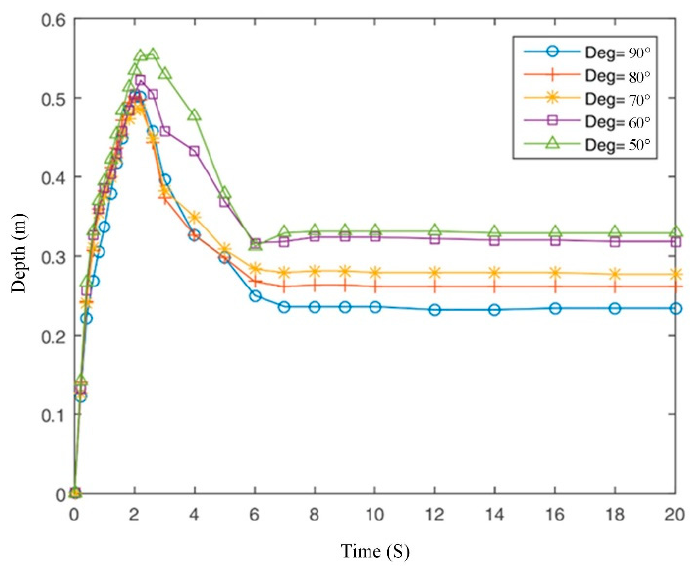
Figure 11. The relationship between scour depth and time at different jet angles.